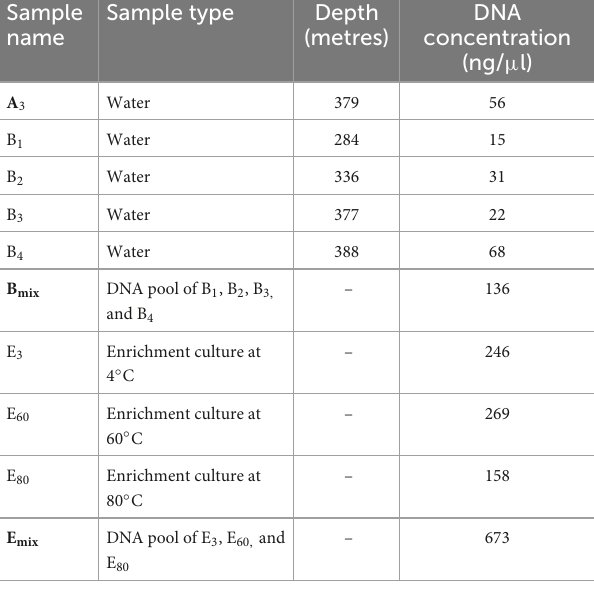
TABLE 1 Sample information from East Skaftárkatlar